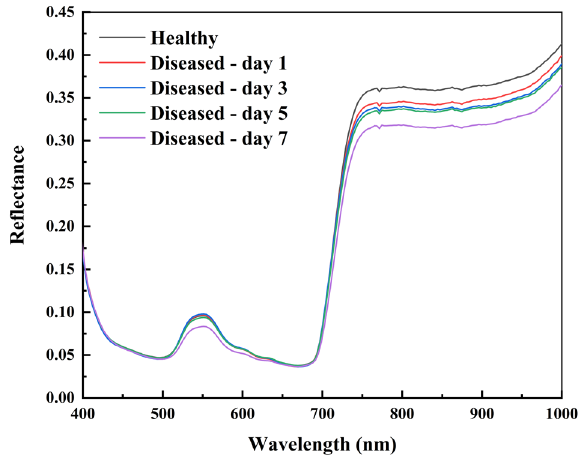
Figure 2. Average spectral reflectance curves of healthy and infected